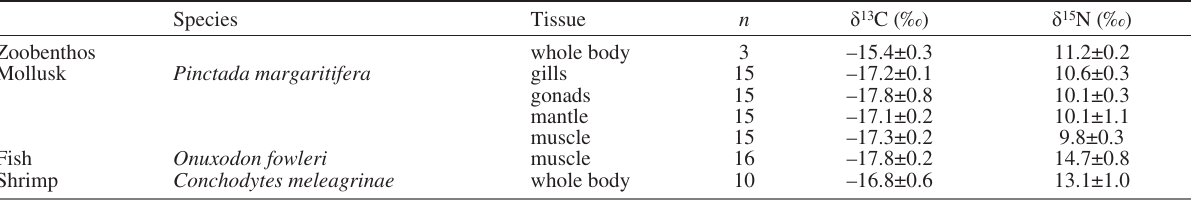
Table 2. – δ 13 C and δ 15 N values (mean±standard deviation) in pearl oysters, carapid fish and selected invertebrates (shrimp and zoobenthos) from Makemo Atoll (French